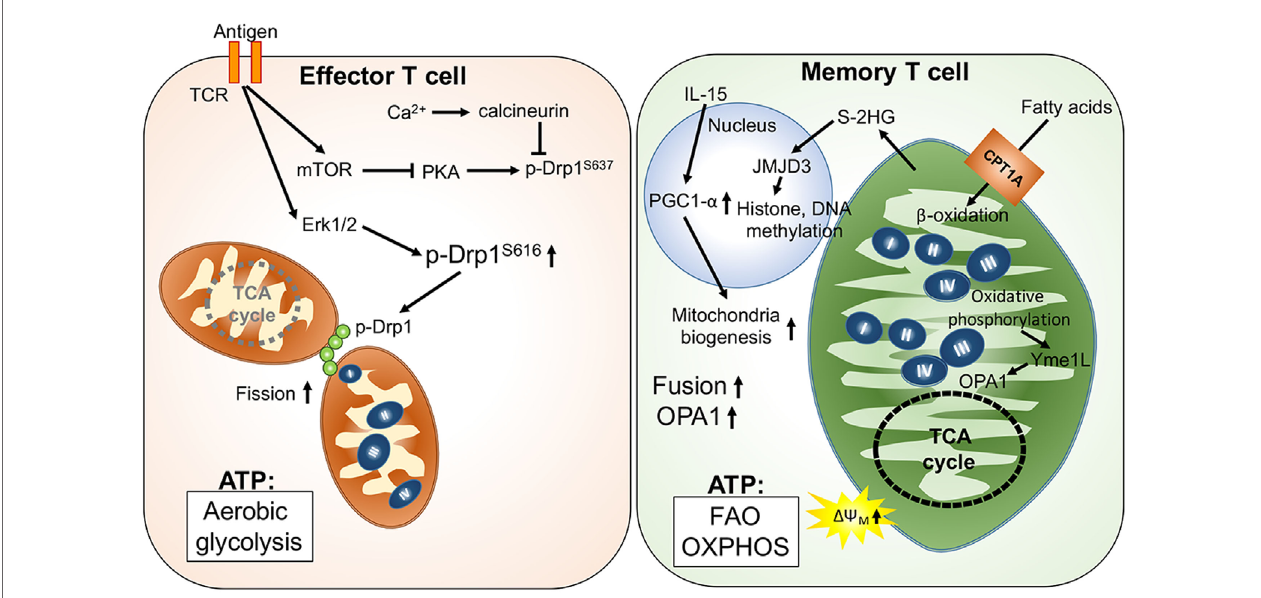
FiGURe 1 | Mitochondria-governed metabolic regulations upon T cell activation and memory T cell formation . T cell receptor (TCR) activation signaling facilitates mitochondrial fission, leading to looser cristae structures, and lower respiratory functions. In this scenario, ATP production is mainly from aerobic glycolysis. By contrast, fusion of mitochondria is facilitated by upregulation of optic atrophy 1 (OPA1)-mediated mitochondrial inner membrane fusion in memory T cells. Furthermore, the tight cristae structure and compact respiratory complex also support maintenance of higher mitochondrial membrane potential ( ΔΨ m) and the oxidative metabolism in